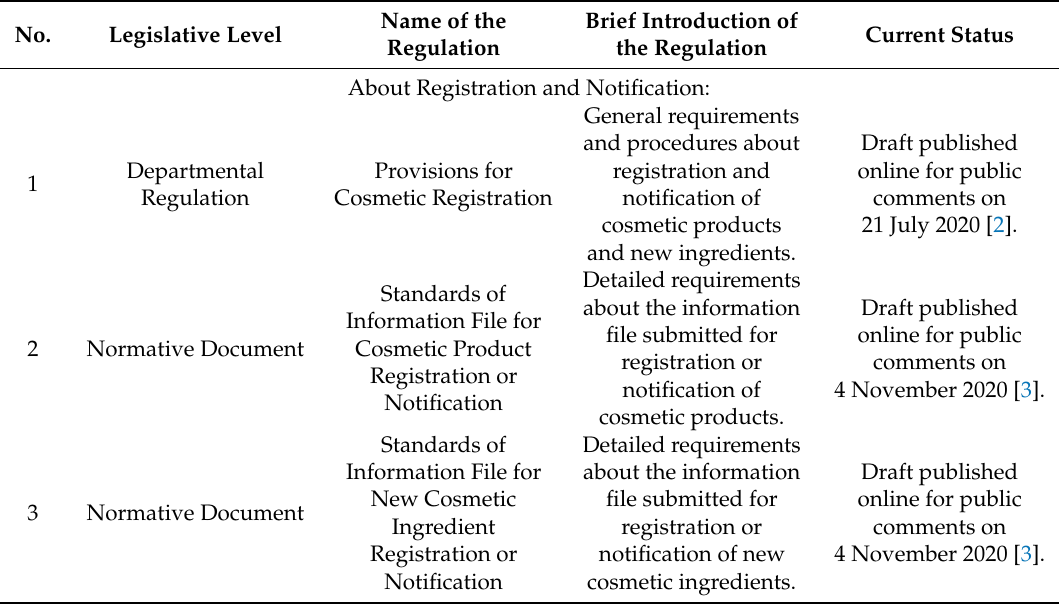
Table 1. Major parts of the CSAR related regulatory